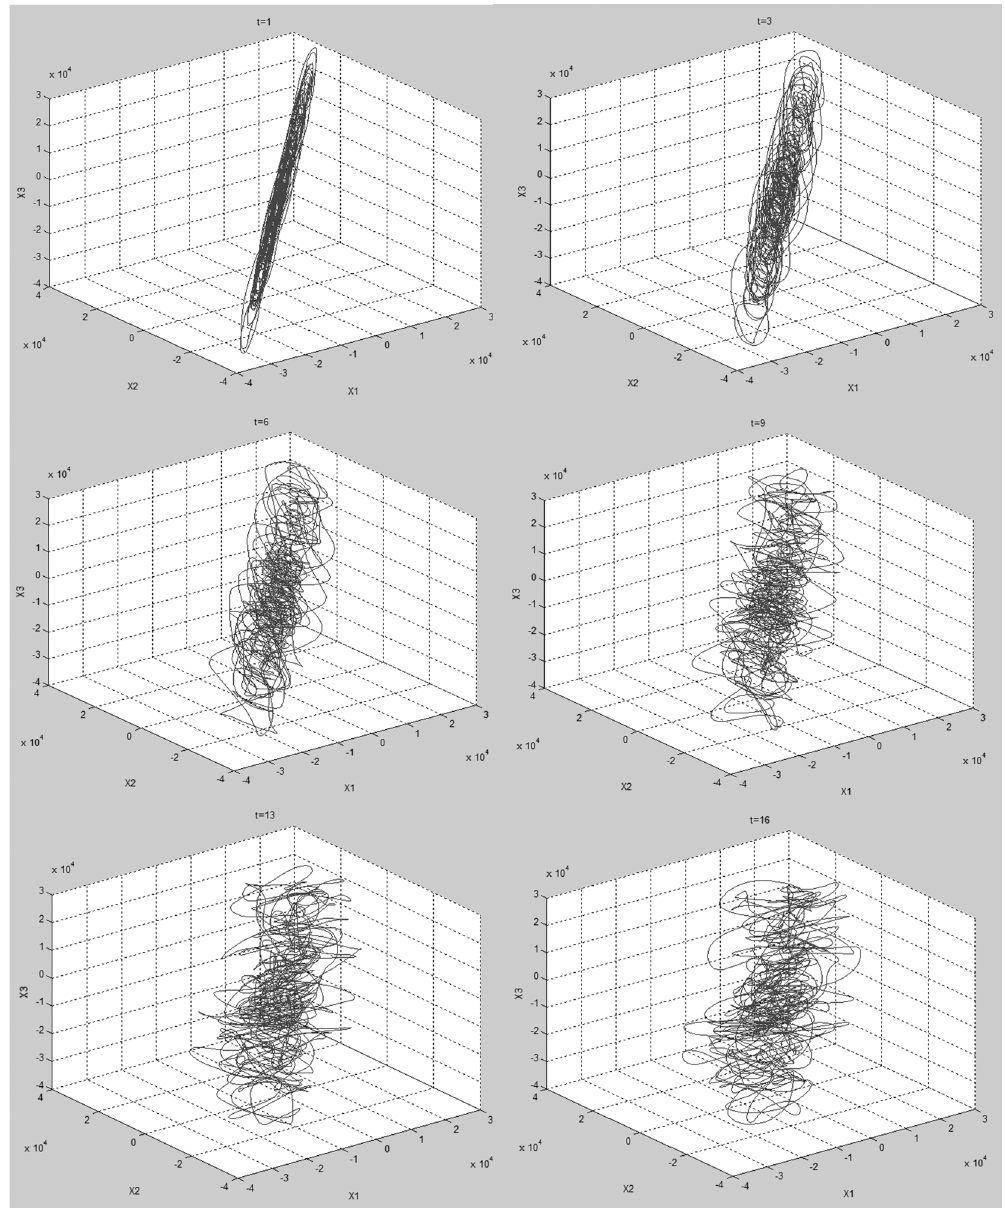
Fig 2. Reconstructed phase space trajectories of a VEP recorded with 3606 Hz sampling frequency embedded in 3 dimensional phase space using different values of τ . From top left to bottom right, τ = 1, 3, 6, 9, 13, 16, 19,